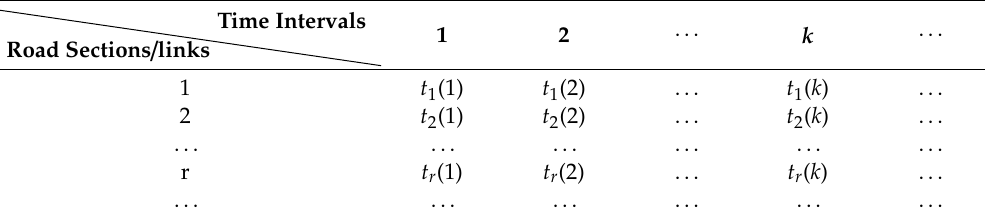
Table 1. Dynamic travel time of each road section.